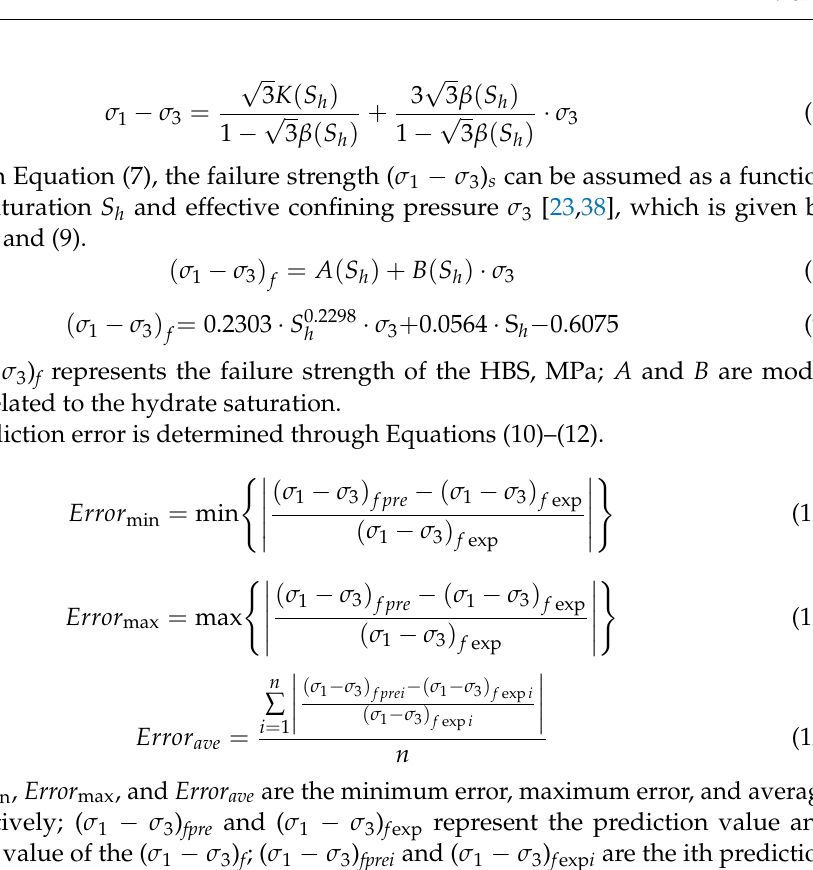
Figure 11. Calculation failure strength with this proposed model. 4.2. Young’s Modulus Prediction Young’s modulus E 50 mainly depends on the hydrate saturation and effective confin- ing pressure [12,47]. Afterwards, Miyazaki et al. [48] established a model to predict the initial elastic modulus, as shown in Equation (13). 